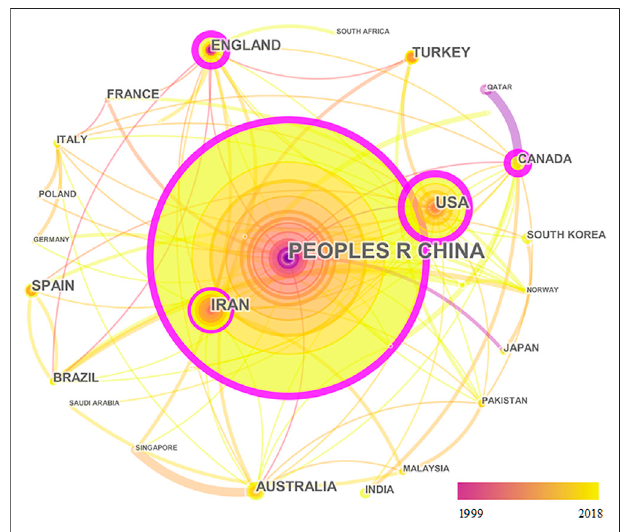
FIGURE 8 | Countries/regions cooperation network in electricity demand